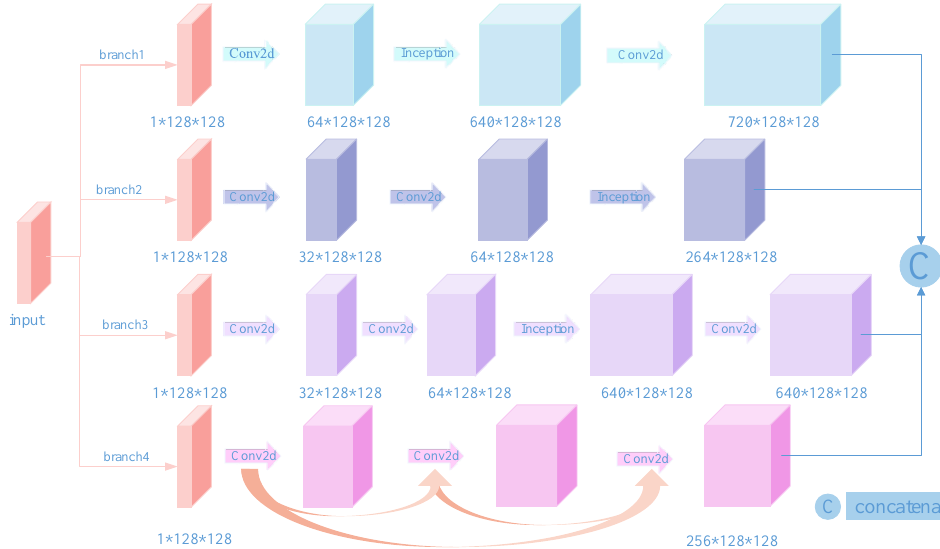
Figure 3. The Encoder Architecture of